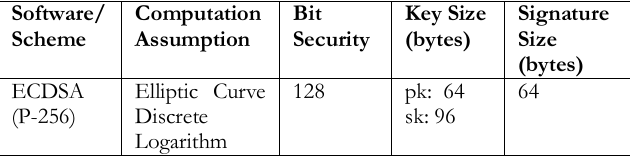
Table 6: ECDSA; signature and key sizes are given in bytes